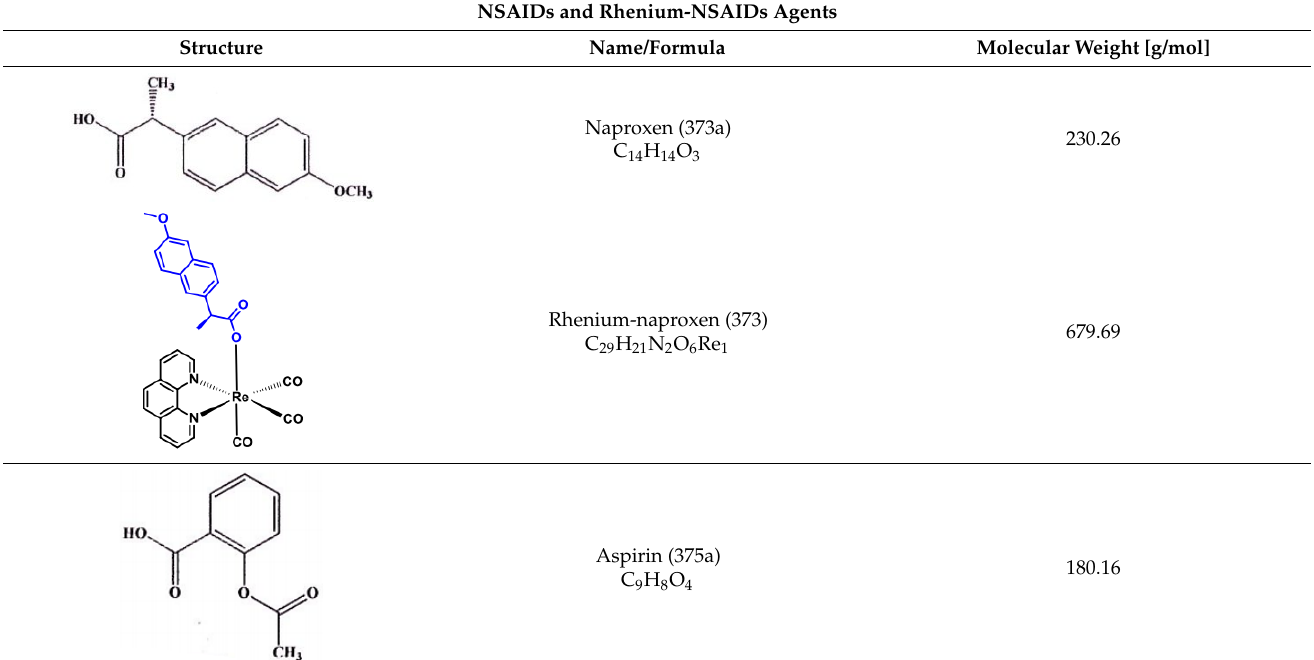
Table 5. NSAIDs and their corresponding rhenium complexes used in cell viability assay of Ishikawa and HEC-1A cell lines.